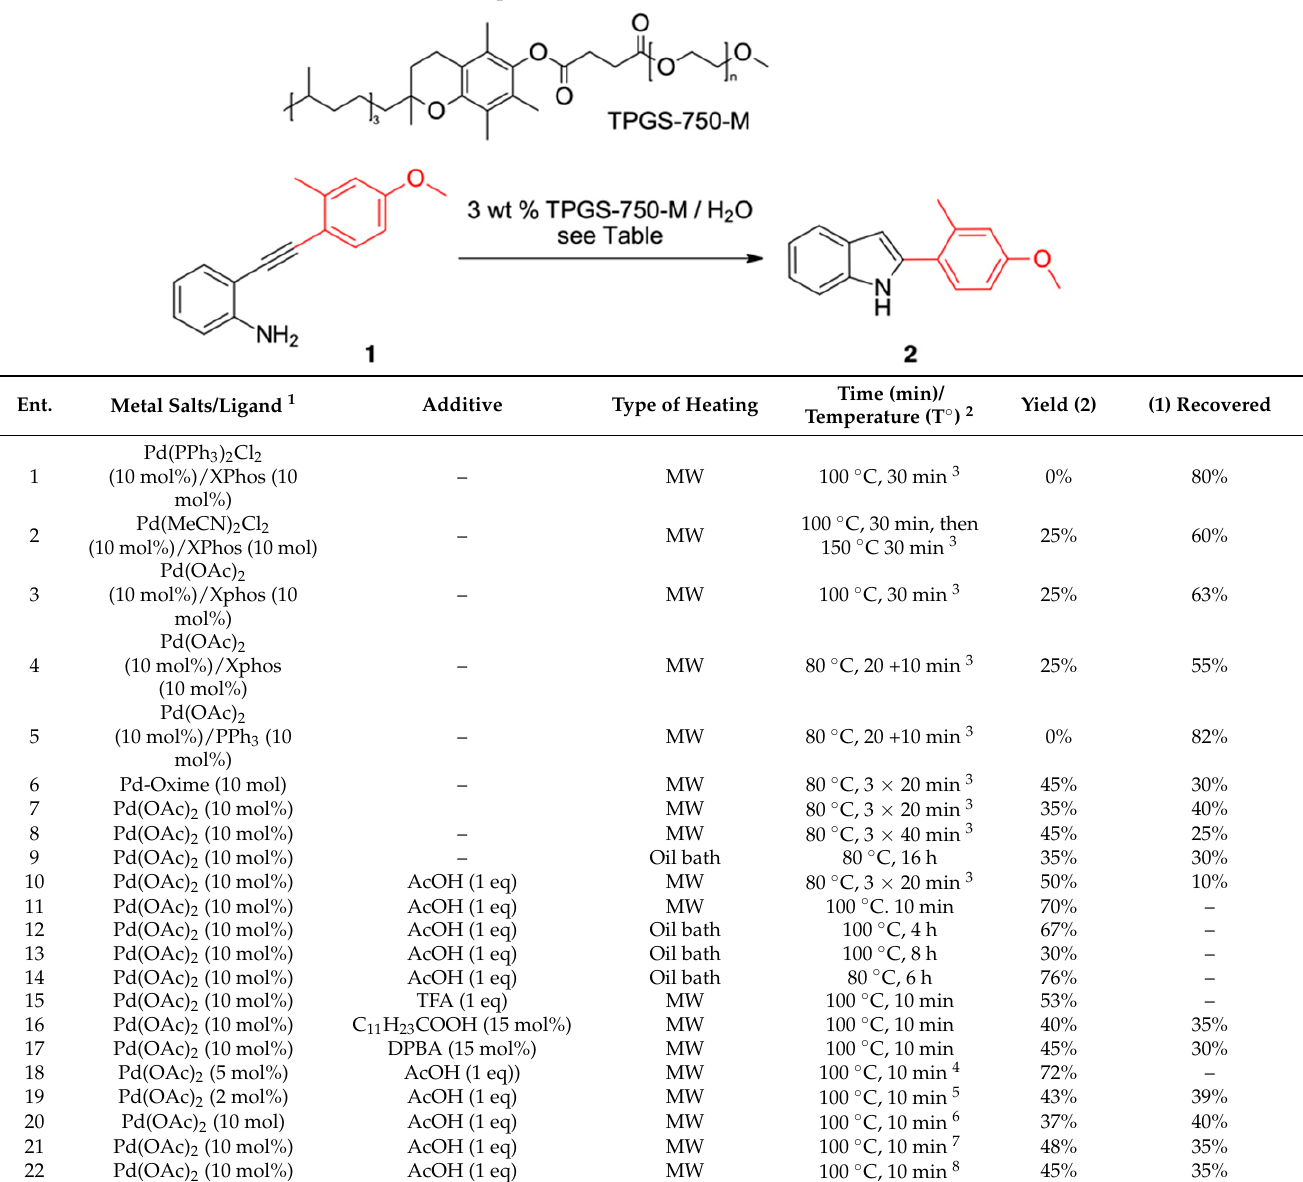
Table 1 . Optimization of reaction Table 1. Optimization of reaction conditions.